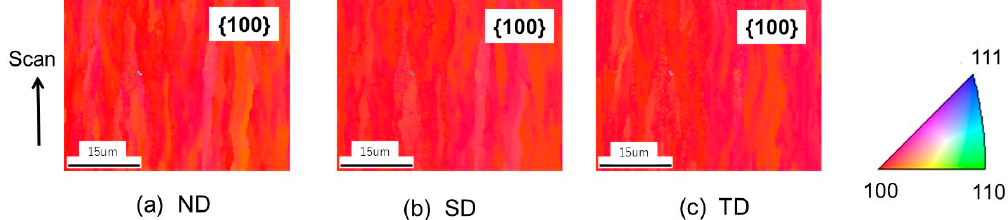
Figure 8. Phase diagram of the {100} texture and mixed texture. The scan velocity was 15 mm/s. After Sasaki et al. [44].